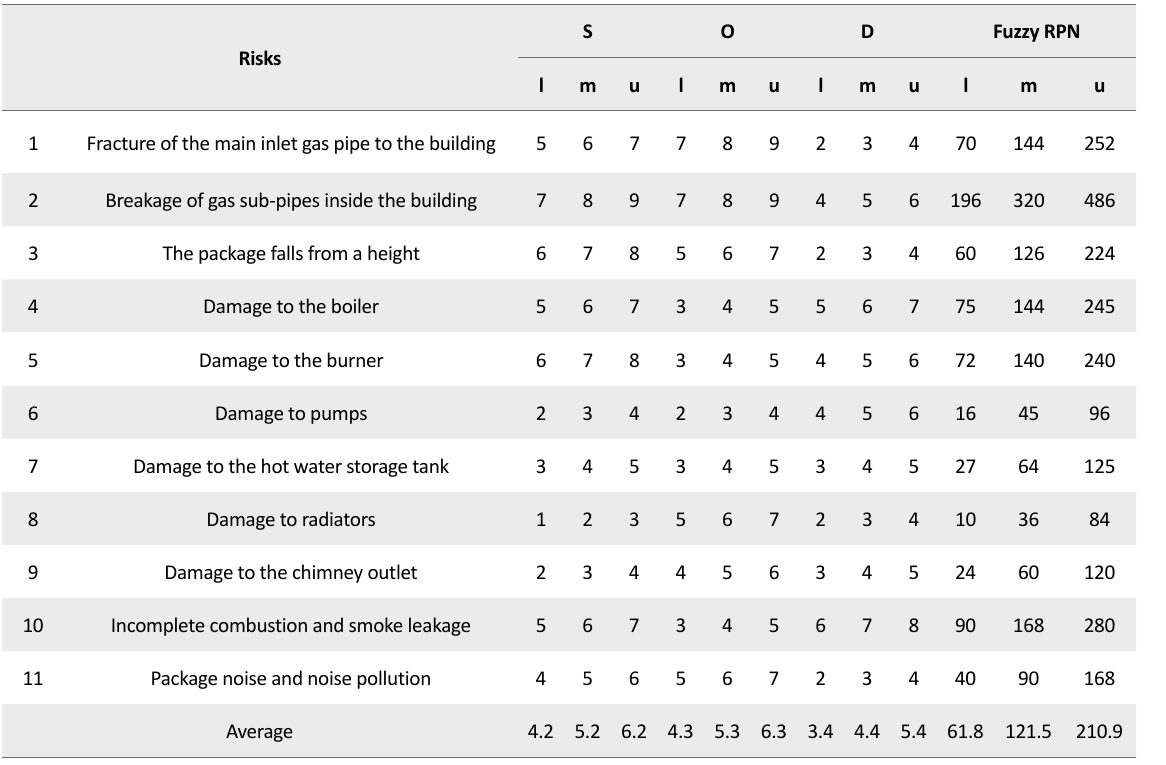
Table 5. Estimated mean scores related to the risks of HP in the fuzzy space